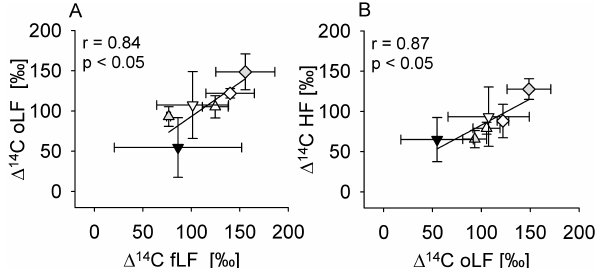
Fig. 3. Relation between the 1 14 C of fLF (free light fraction) and oLF (occluded light fraction) (left, A ), and between the OC of the oLF and HF (heavy fraction, B ) at 0–5cm soil depth. Only undis- turbed sites having no fossil C are shown (Hainich, Hesse, Sorø, Bugac, Laqueuille, Norunda; black: coniferous forest, dark grey: croplands, light gray: grasslands, white: deciduous